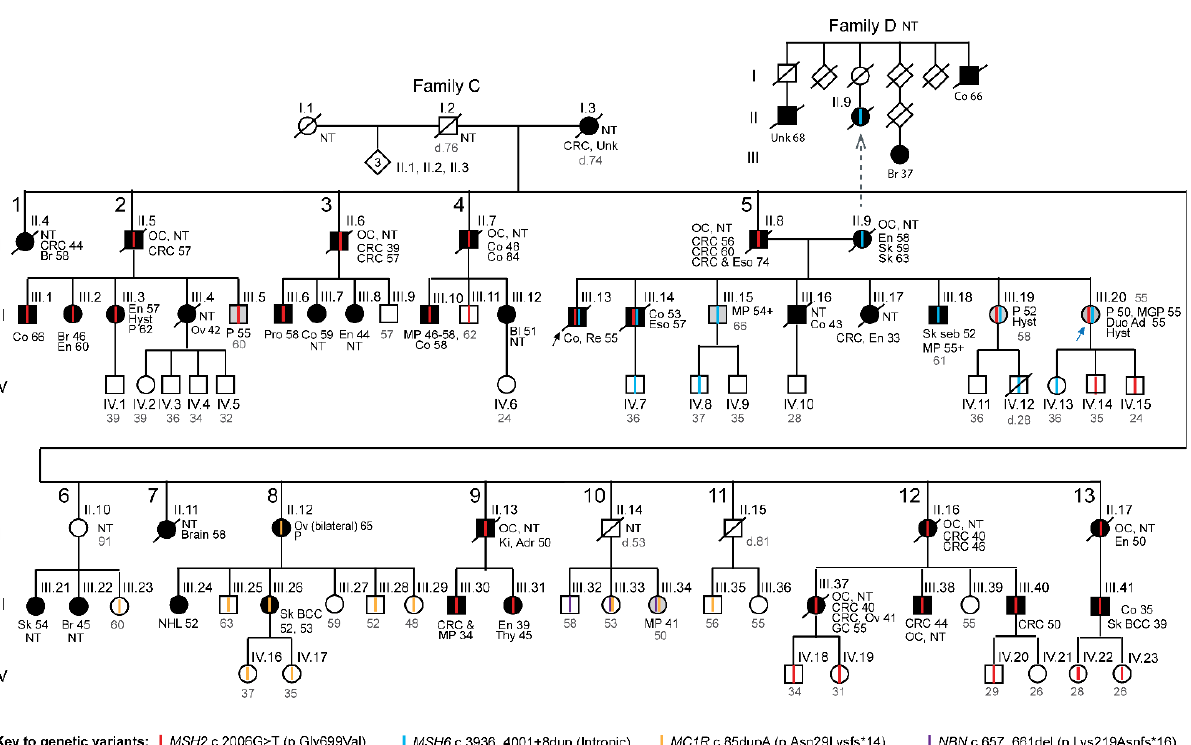
Figure 1. Pedigree showing cancer family history and carriage of cancer-associated genetic variants. Shown are four generations (labeled I–IV) of “Family C” (main figure) and three generation (I–III) of “Family D” (top right), linked by marriage. Family C is a large family carrying the MSH2 c.2006G>T variant in which additional cancer-associated variants were found. Persons are labeled with the generation and a designated number for reference. Each branch descending from the cancer-affected female in generation I (the likely ancestral carrier of MSH2 c.2006G>T) is numbered 1–13. Due to the size of the main pedigree, the figure is split with branches 1–5 shown above, and branches 6–13 shown below. All persons in generations I-III are included, however, those who did not consent to join the study are shown as diamonds to preserve privacy. Only members of generation IV who consented to join the study are included in the pedigree, to preserve privacy. Age in years at close of study is given in gray beneath each symbol for those unaffected by cancer or under ongoing follow-up. Age in years at death (d.), where relevant, is provided in gray. All members of generation IV were under 40 years of age at close of study. Closed black symbols represent cancer-affected members with cancer diagnosis given alongside or below as follows: CRC, colorectal cancer; Co, colon; Re, rectal; En, endometrial; Br, breast; Eso, esophageal; Sk, skin (of unknown histology); Seb, sebaceous carcinoma of the skin; BCC, basal cell carcinoma; Ov, ovarian; Ki, kidney, Adr, adrenal gland; GC, gastric; Pro, prostate; Bl, bladder; NHL, non-Hodgkin’s lymphoma; Thy, thyroid. Gray symbols represent a precancerous lesion identified during endoscopic surveillance, as follows: P, colorectal polyp(s); MP, multiple colorectal polyps; MGP, multiple gastric polyps; Duo Ad, duodenal advanced adenoma. Age at diagnosis (number) in years provided in black text alongside or beneath. + indicates multiple diagnoses of polyps above the age shown for first diagnosis. Unk = age at cancer